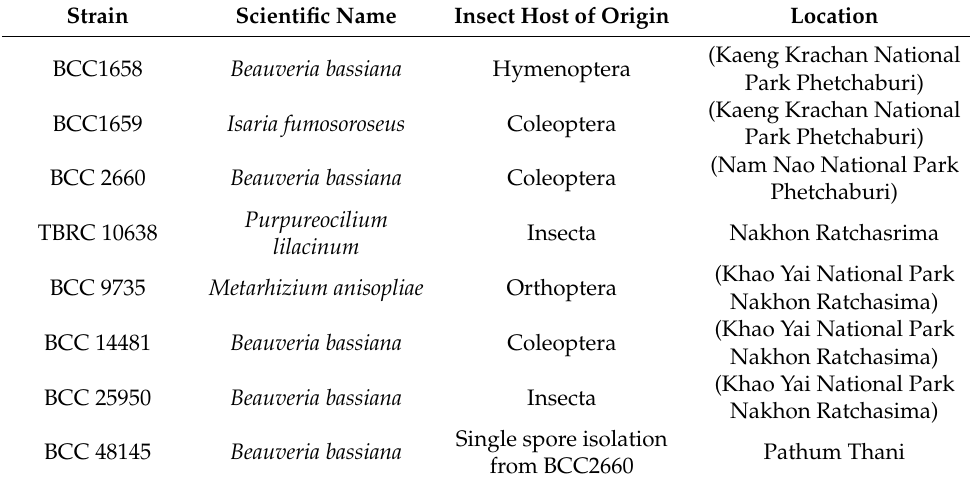
Table 1. List of fungal strains selected for laboratory screening against S. dorsalis